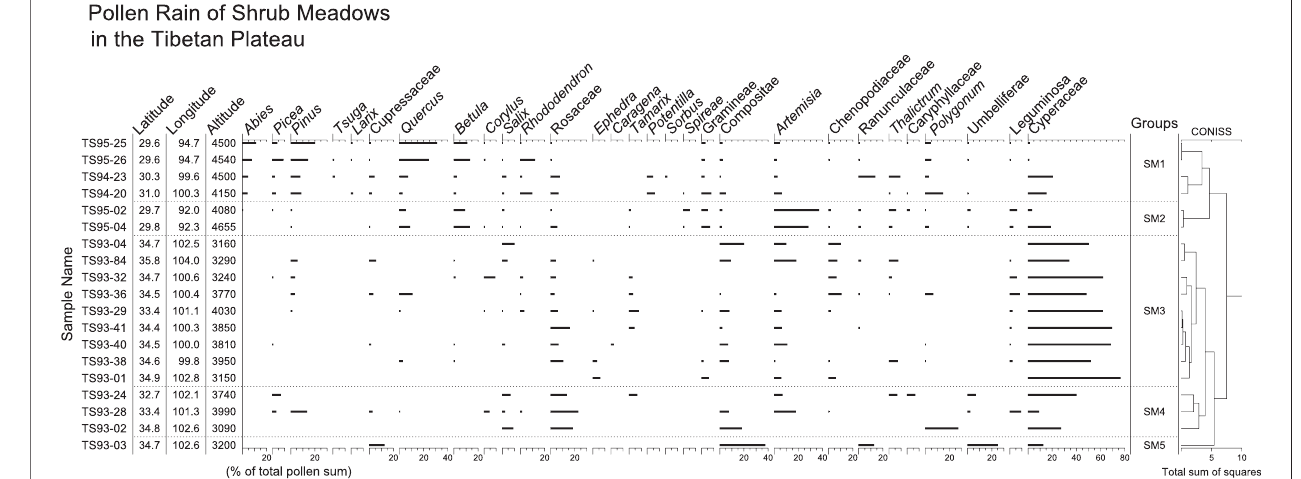
FIGURE 5 | Pollen percentage diagram for surface samples from shrub meadows in the TP. Samples of groups SM1 and SM2 are from the southeast, and the others (SM3, SM4, and SM5) from the northeast.